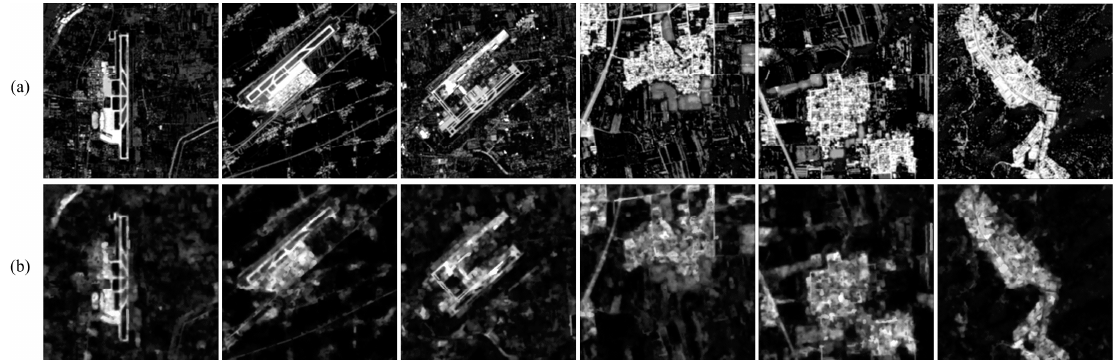
Figure 3. Information saliency maps and spectrum saliency maps: ( a ) information saliency maps; ( b ) spectrum saliency maps.